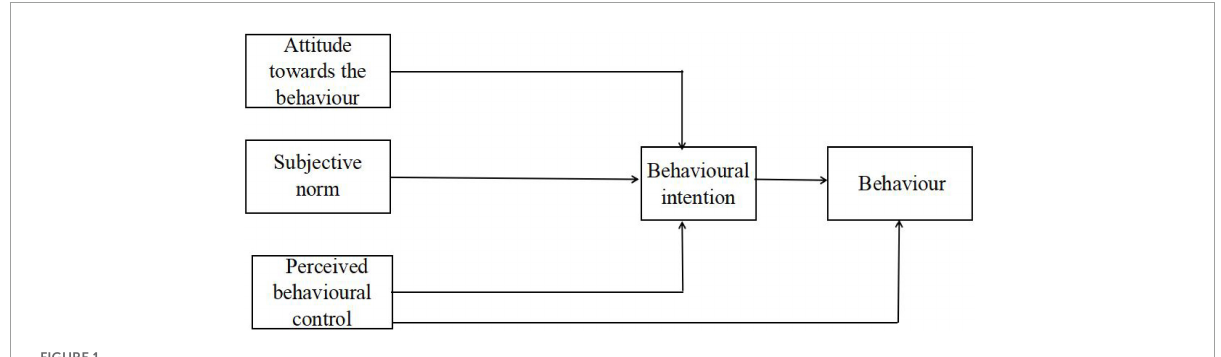
FIGURE1 The theory of planned